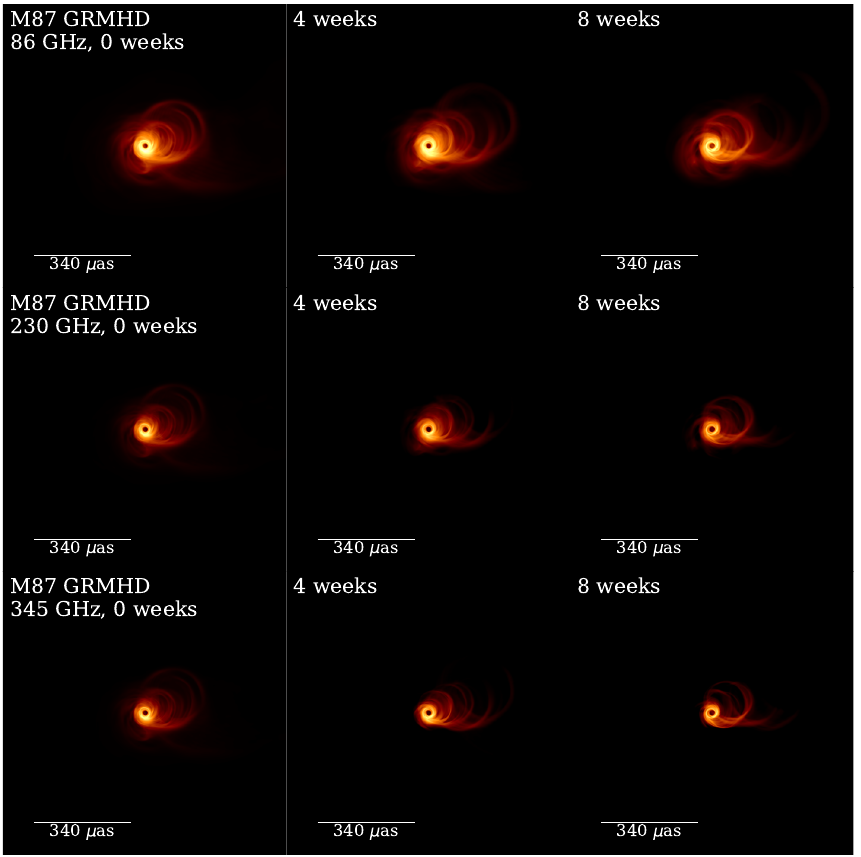
Figure 6. Ground truth M87 source models used for Challenge 2. For each frequency, three movie frames are shown. Images are shown on a log scale, which is normalized to the brightest pixel value across each set of three movie frames, with a dynamic range of 10 3.5